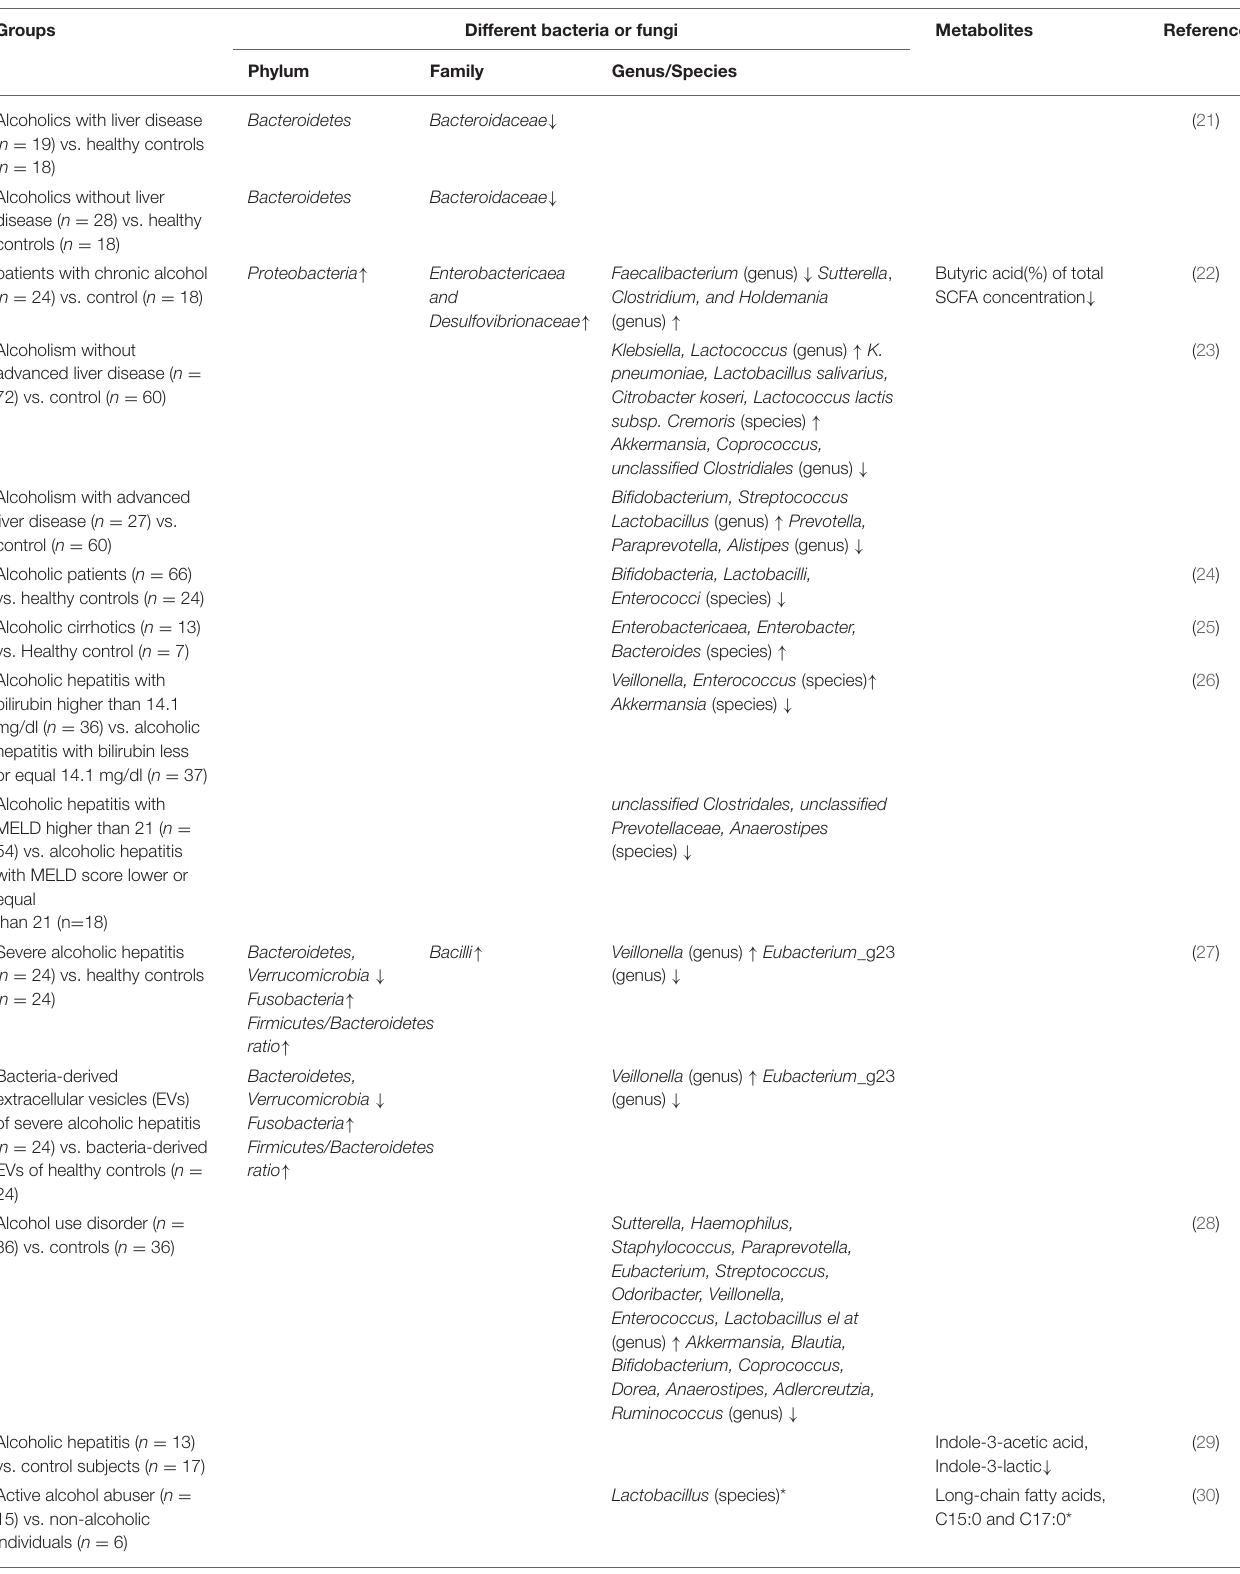
TABLE 1 | Changes in intestinal bacteria or fungi and associated metabolites in patients with alcoholic liver disease.